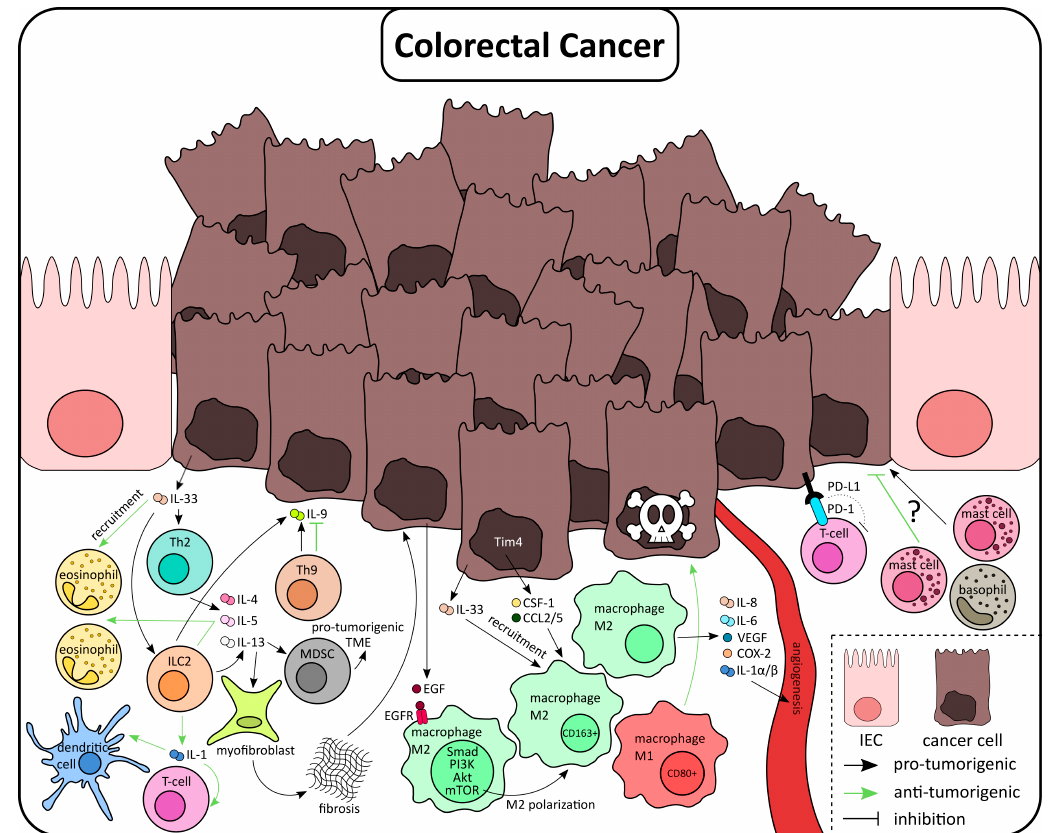
Figure 3. Schematic representation of IECs and immune cell crosstalk, mediated by type 2 cytokines, during colorectal cancer. Type 2 immune responses exhibit pro- and anti-tumorigenic effects during colorectal cancer development. Akt, protein kinase D; COX-2, cyclooxygenase 2; CSF-1, colony-stimulating factor 1; EGF, epidermal growth factor; MDSC, myeloid-derived suppressor cell; mTOR, mammalian target of rapamycin; PD-1, programmed cell death protein 1; PD-L1, programmed death ligand 1; PI3K, phosphatidylinositol 3-kinase; TIM4, T-cell immunoglobulin and mucin domain containing 4; TME, tumor microenvironment; VEGF, vascular endothelial growth factor. A major immune cell population infiltrating tumor tissue in CRC is